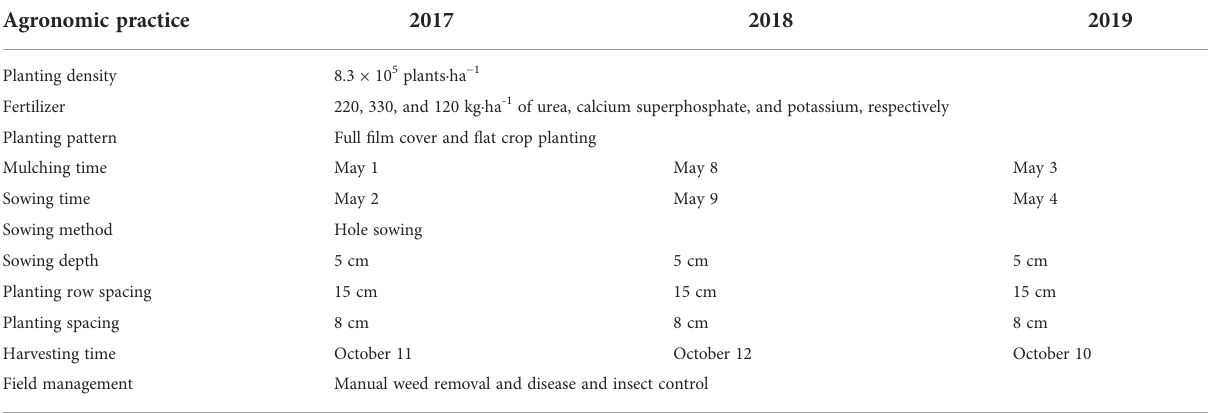
TABLE 2 Agronomic practices employed for I. indigotica cultivation in experimental fi eld plots at Minle of Gansu Province,